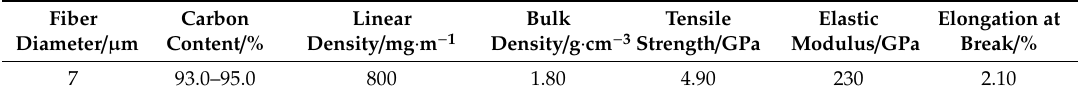
Table 1. Main performance parameters of carbon fibers.